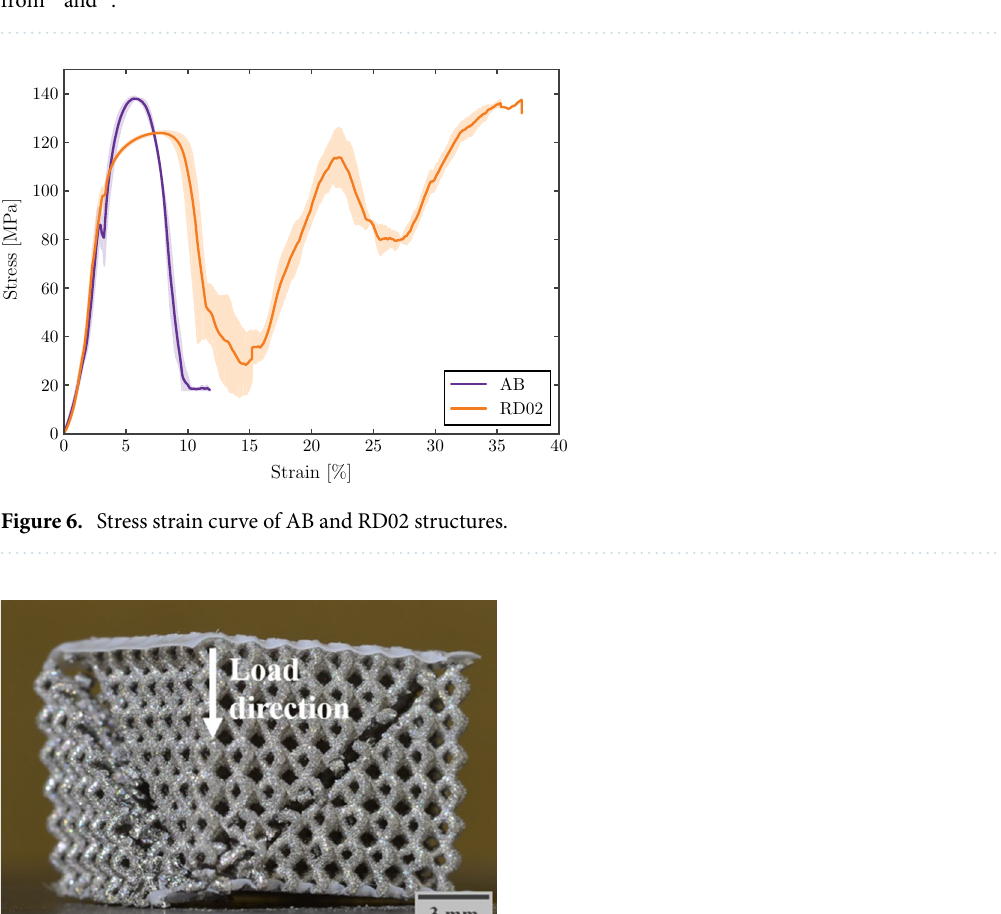
Figure 5. Gibson Ashby curves of FCCm and other bending dominated unit cells made of Ti6Al4V obtained from 35 and 36 .